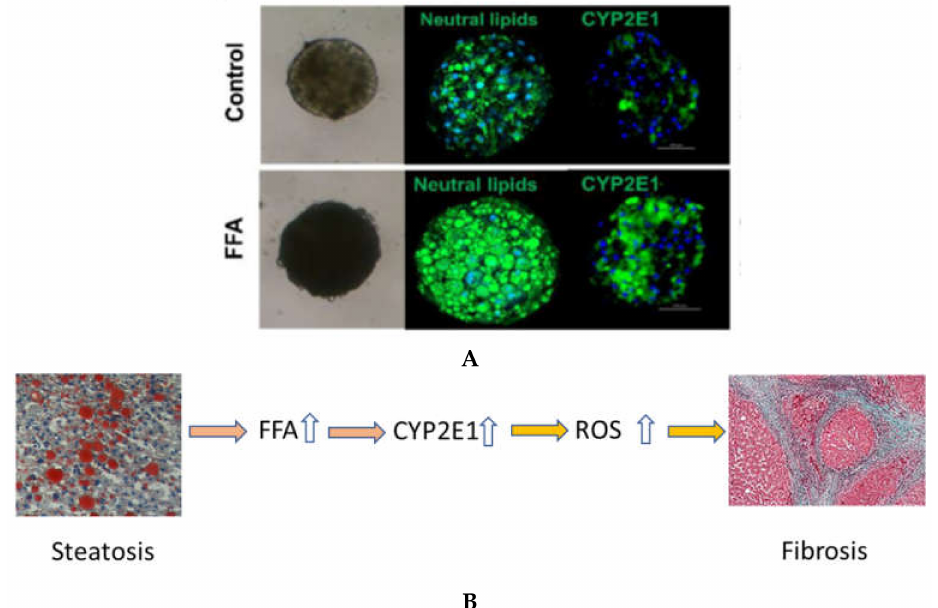
Figure 5. Suggested link between steatosis and liver fibrosis mediated by elevated levels of CYP2E1 caused by increase production of fat. ( A ) Exposure to FFA in human 3D liver spheroids causes elevated levels of lipids and increase expression of CYP2E1 (From [164]). ( B ) Proposed involvement of CYP2E1 in mediating increased liver fibrosis in response to elevated levels of hepatic lipids in steatosis. Upwards arrows represent an increased number of molecules or greater expression. Figure modified from